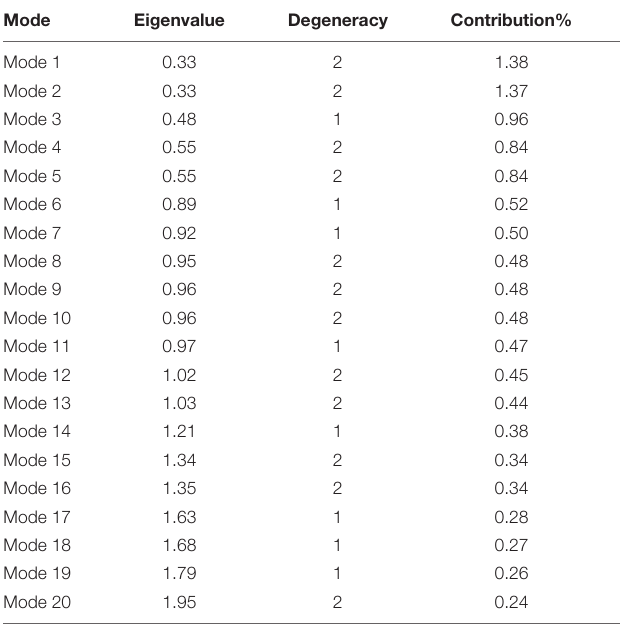
TABLE 1 | PTPS first 20 non-trivial normal modes, associated eigenvalues, and level of degeneracy.